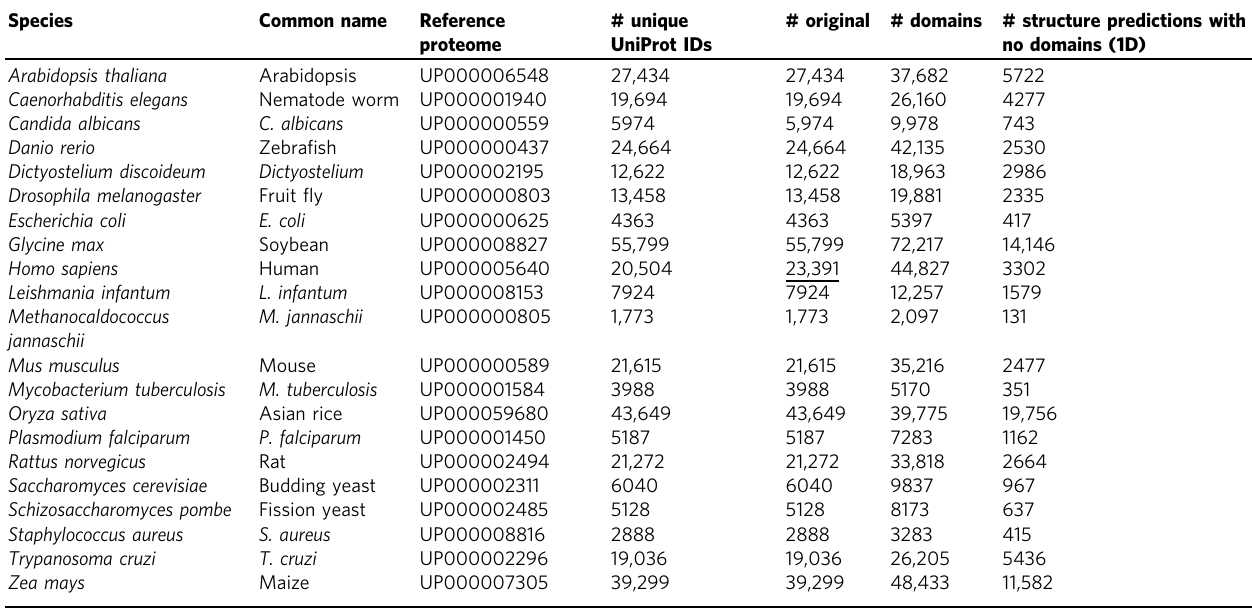
For each proteome, the number of unique proteins, total original/domain models, and total original models containing no con fi dent domains are given. The de fi nition of the con fi dent domains is given in themaintext.Thehumanoriginalmodelcountisunderlined,indicatingthatthenumberoforiginalmodelsdoesnotmatchthenumberofuniqueproteins.Thehumanstructurepredictionsretrievedfrom the AlphaFold Database contain models which are 1400-residue slices of larger